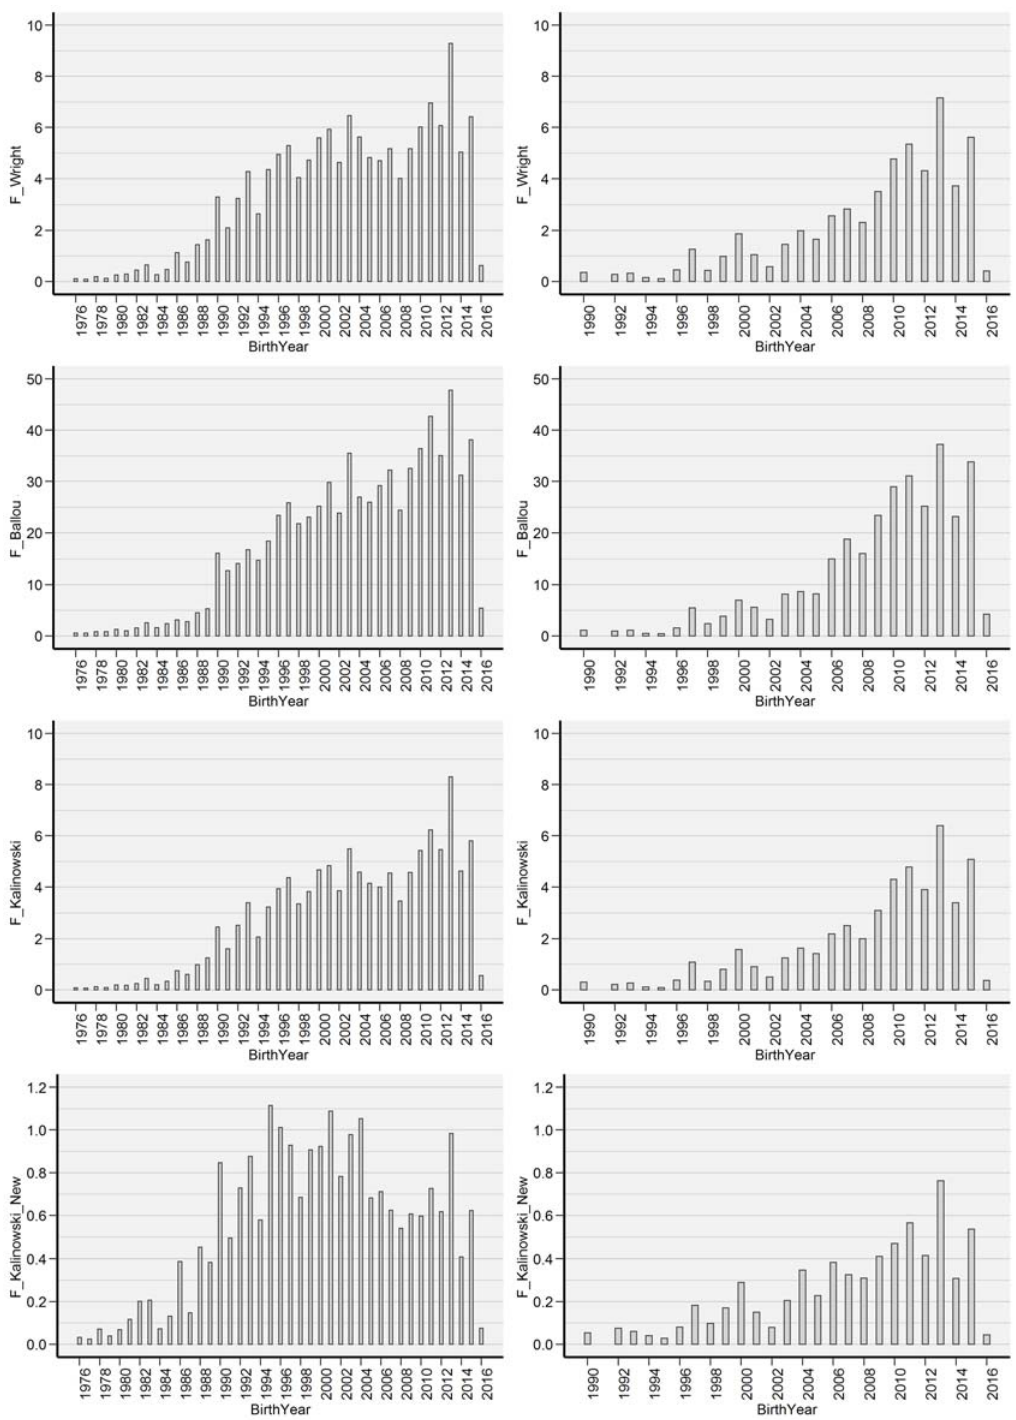
Figure 2. The estimated ancestral inbreeding coefficients by birth year in the total (left) and the reference (right) populations.